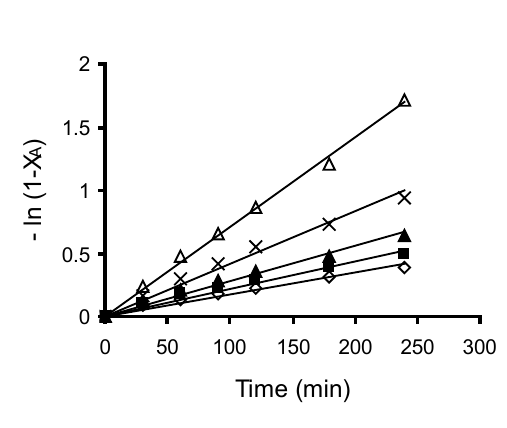
Figure 8. Change of the real concentration for acetic acid in time; speed of agitation: 600 rpm; catalyst loading (112.5 kg m -3 ); temperature 366 K, molar ratio acetic acid : ep - ichlorohydrin 1:10.